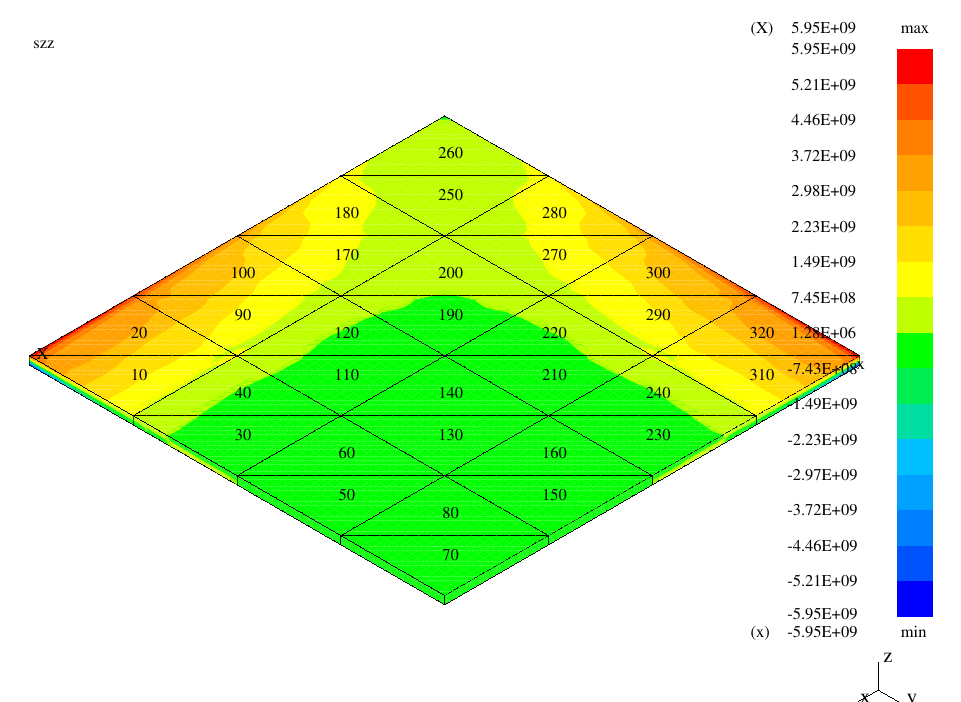
Figure 12. Transverse stress—the bent plate with the modified transition elements.